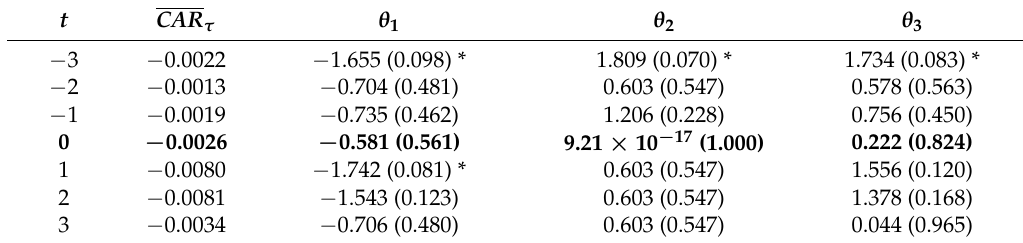
Table 4. Stock market reactions to Brexit, CEE regional factor, three-day window